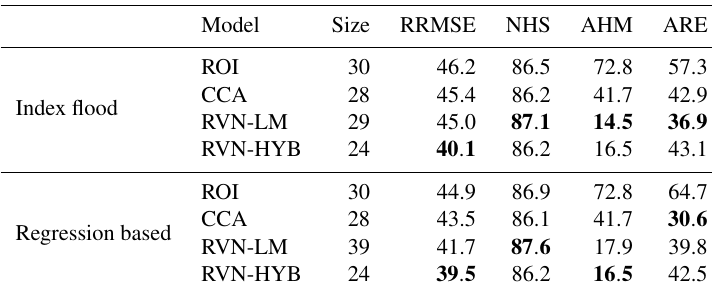
Table 1. Evaluation criteria for the RVN method for optimal neighbourhood sizes.